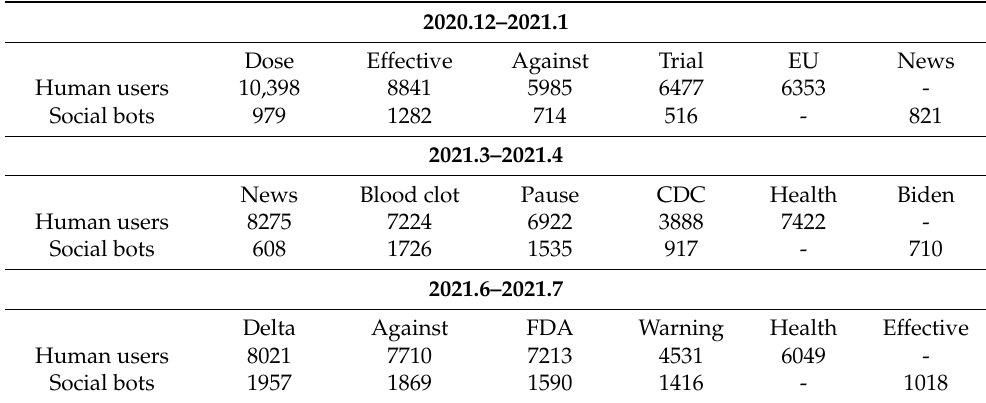
Table 2. High-Frequency Words of Social Bots and Human Users in Three